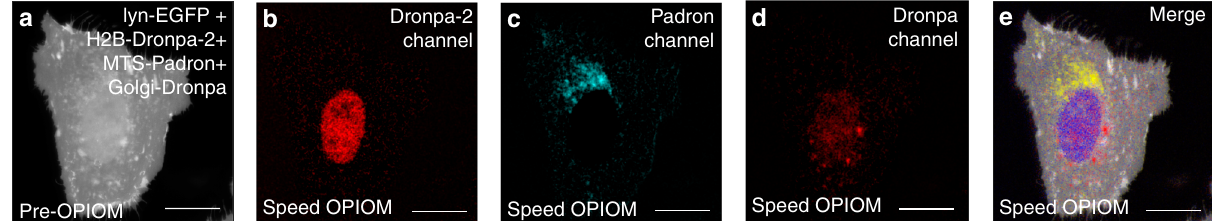
Fig. 6 Speed OPIOM can independently image four spectrally similar fl uorescent proteins without high-contrast enhancement. Pre-OPIOM ( a ) and speed OPIOM images tuned to selectively image Dronpa-2 ( b ), Padron ( c ), and Dronpa ( d ). In e , overlay between the pre-OPIOM image from the Dronpa-2 acquisition and speed OPIOM images collected in ( b – d ). Systems: Fixed U2OS cells expressing H2B-Dronpa-2, Mito-Padron, Dronpa-GTS, and Lyn11-EGFP. Localizations: H2B (nucleus), Lyn11 (cell membrane), Mito (mitochondria), GTS (Golgi). The images were recorded at 37 °C. Scale bars : 20 µ m.